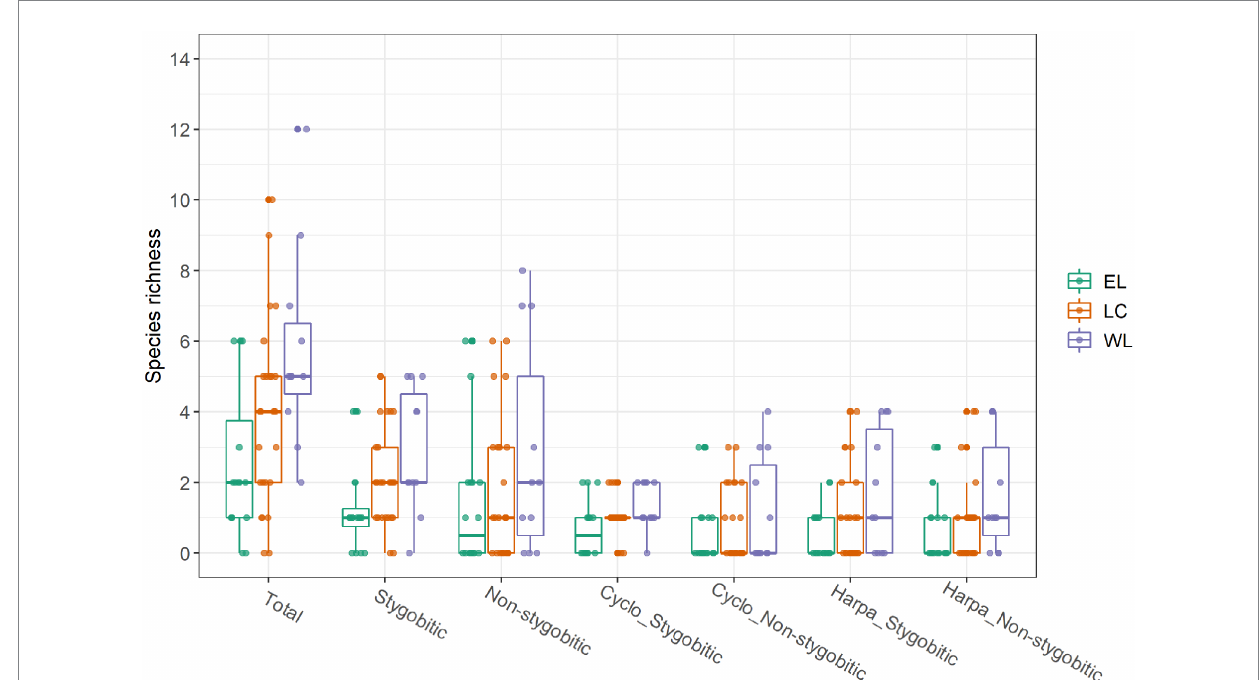
FIGURE 2 Taxonomic richness across the caves sampled from the three basins (Eastern Lessini – EL; Lessinian Core – LC; Western Lessini – WL), considering overall copepod species richness (Total); richness of stygobitic or non-stygobitic copepod species; richness of stygobitic (Cyclo_Stygobitic) or non- stygobitic (Cyclo_Non-stygobitic) species belonging to Cyclopoida; richness of stygobitic (Harpa_Stygobitic) or non-stygobitic (Harpa_Non-stygobitic) species belonging to